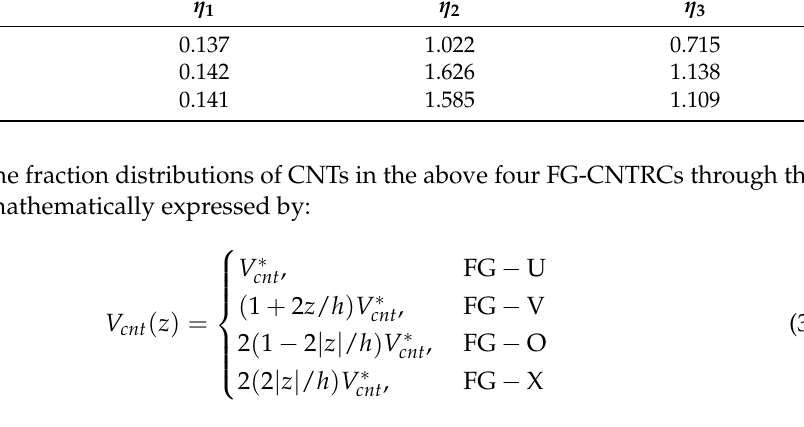
Table 1. The CNT efficiency parameters η j for three different values of V ∗ 300 K ). V * cnt η 1 η